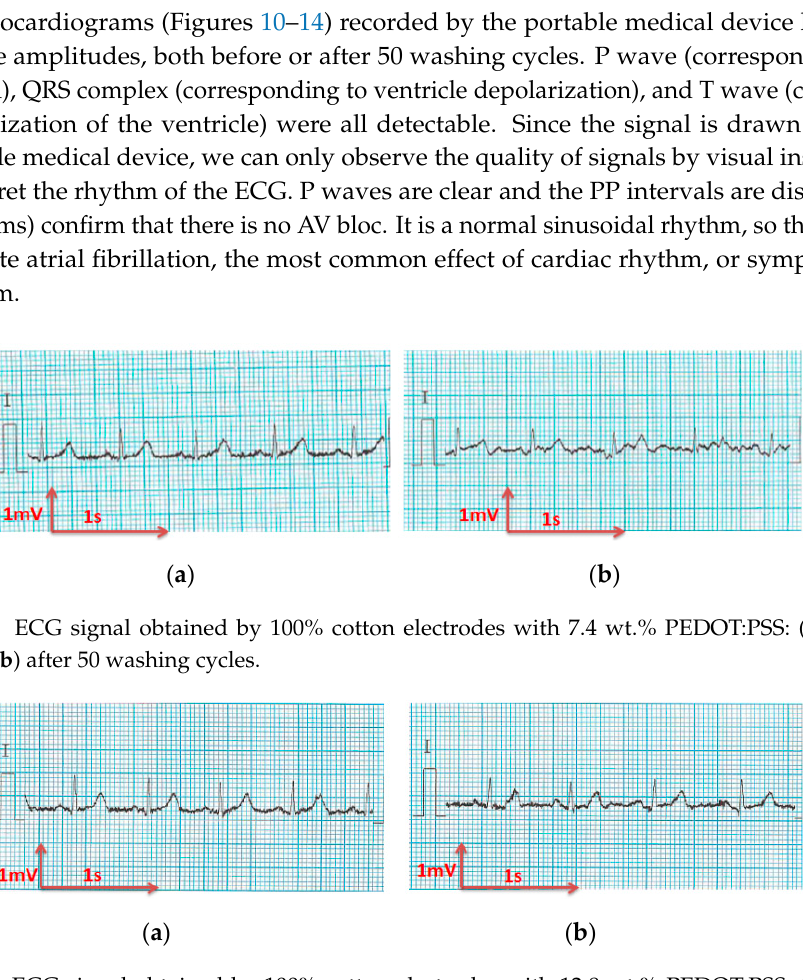
Figure 9. General waveform of an electrocardiogram (ECG).